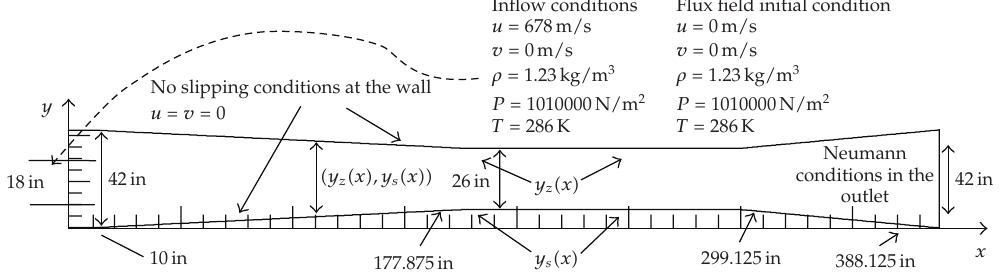
Figure 10: Ejector plane with the initial